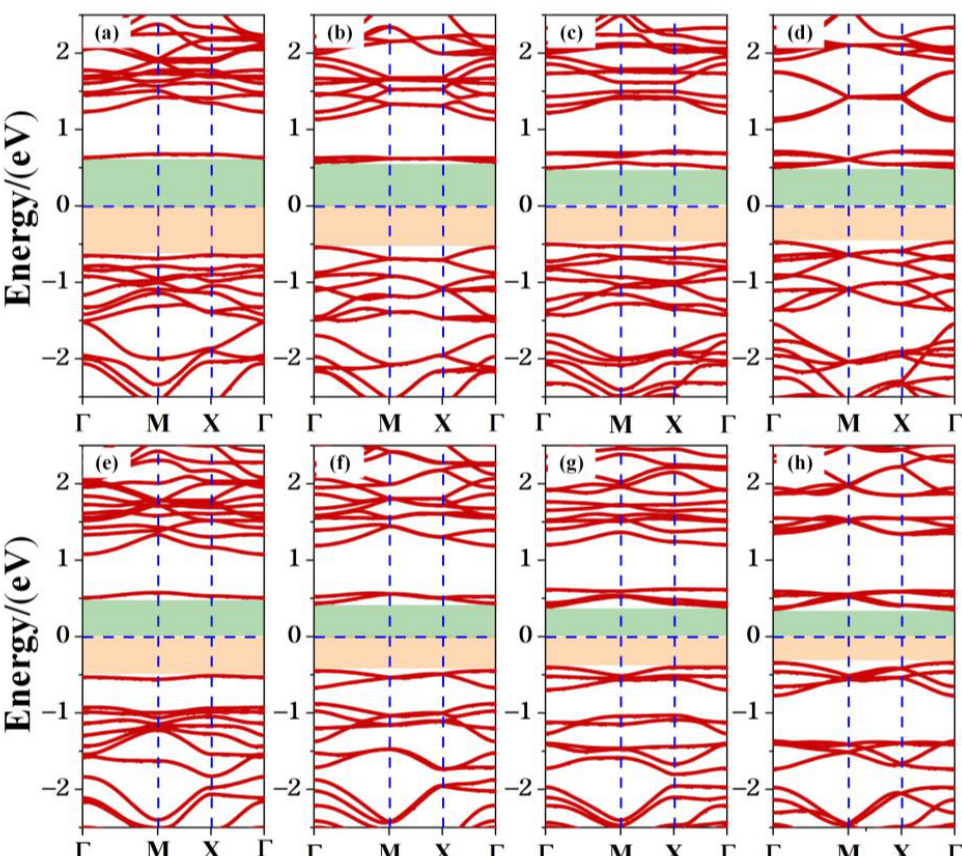
Figure 5. Electronic band structure of co-doped TTG systems. ( a ) TTG/BP-para-4.2%; ( b ) TTG/BP- para-8.3%; ( c ) TTG/BP-para-12.5%; ( d ) TTG/BP-para-16.7%; ( e ) TTG/BP-ortho-4.2%; ( f ) TTG/BP- ortho-8.3%; ( g ) TTG/BP-ortho-12.5%; ( h ) TTG/BP-ortho-16.7%.